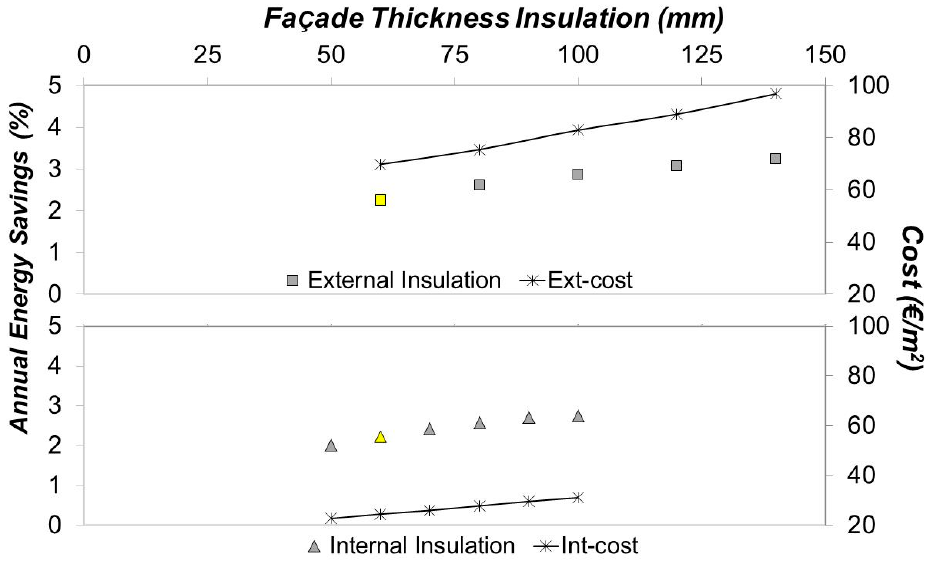
Figure 2. Energy savings and economical prices for added external or internal insulation to the